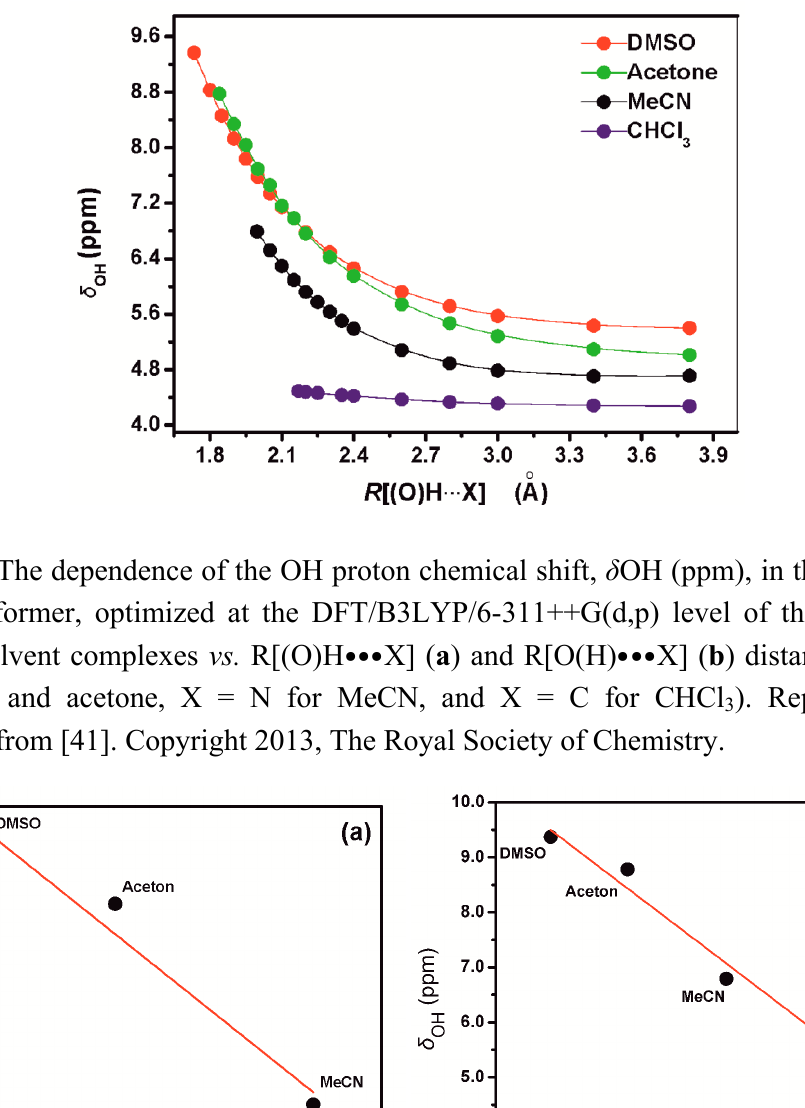
X] (X = O for DMSO (red) and (blue). Reprinted with 3 •••